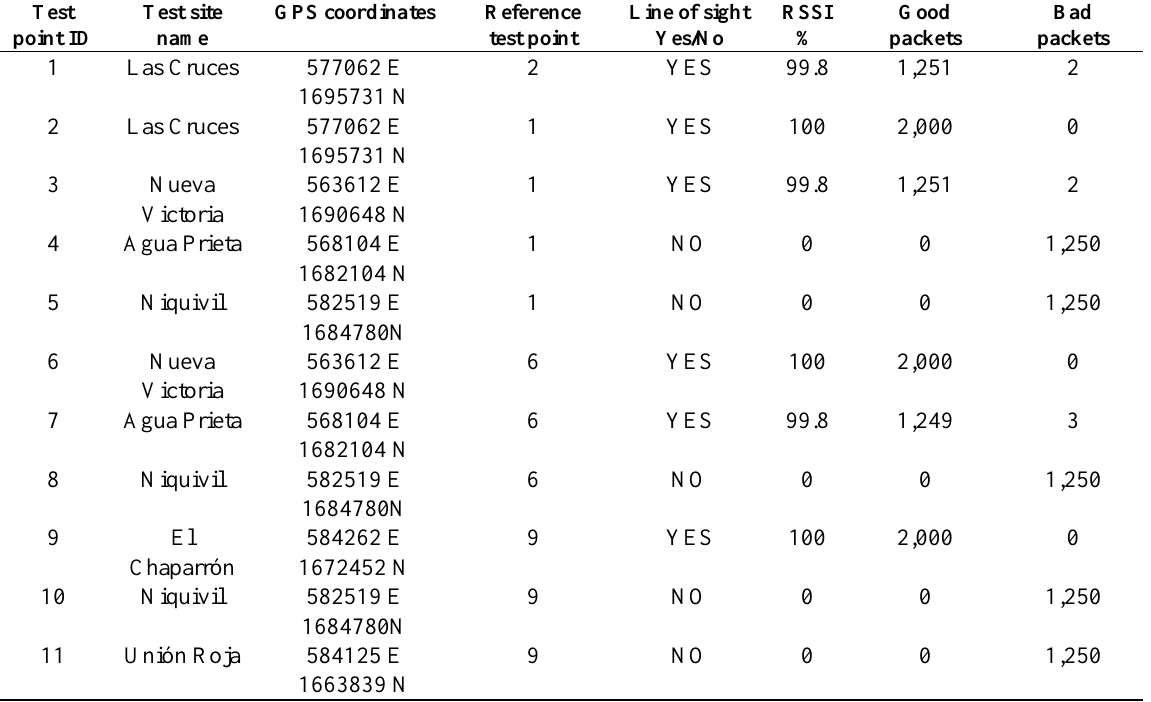
Table 2. Field measurement results in the selected RTU installation